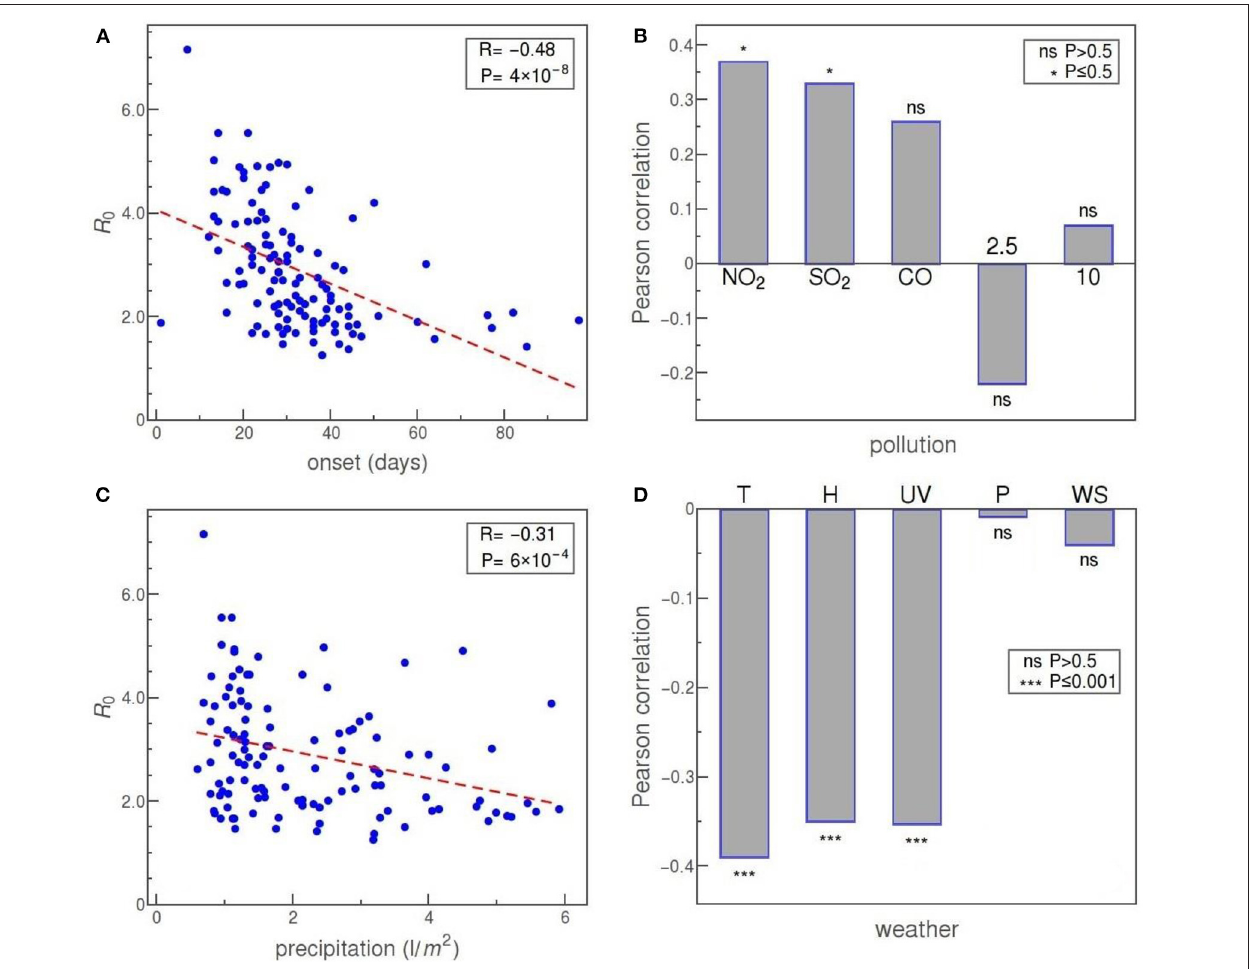
FIGURE 6 | (A) R 0 vs. the time delay of epidemic onset. (B) Pearson correlation of R 0 with pollutants (from left to right): NO 2 , SO 2 , CO, PM2.5, and PM10 (inhalable particles with 2.5 and 10 µ m, respectively). (C) R 0 vs. precipitation. (D) Pearson correlation of R 0 with (from left to right): temperature, specific humidity, UV index, air pressure, and wind speed. The convention for representing the statistical significance of each correlation is the same as